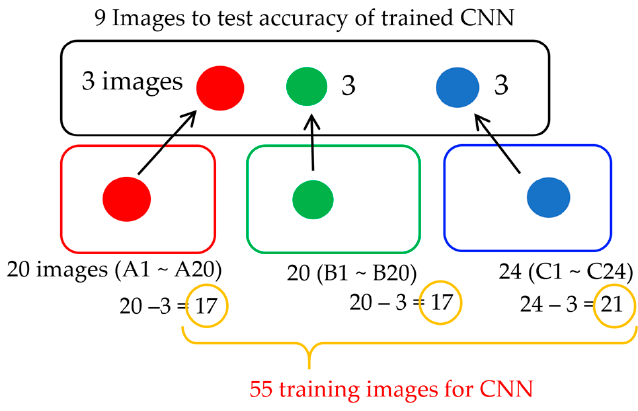
Figure 9. Overview of repeated random subsampling validation.